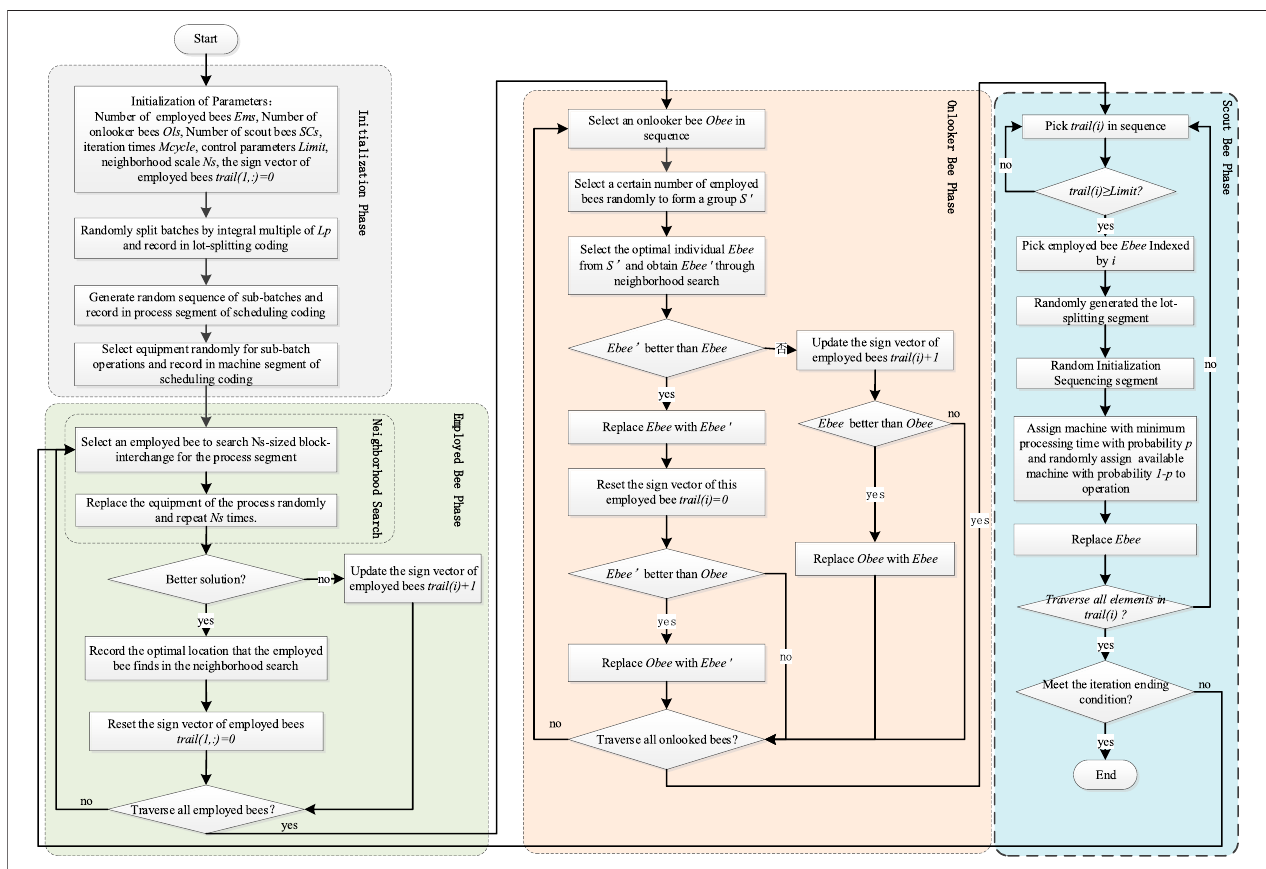
FIGURE 2 | Framework of improved algorithm based on an arti fi cial bee